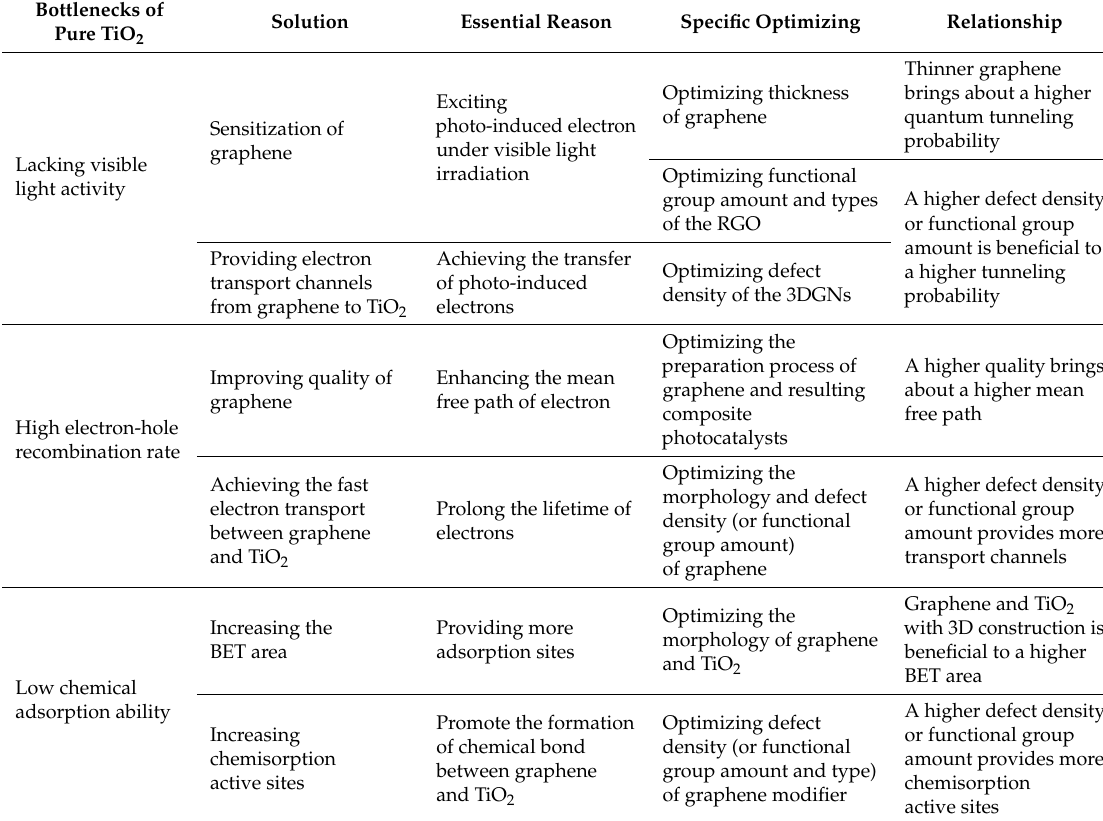
Table 1. Relationship between photocatalytic performances and optimization technologies. Bottlenecks of Pure TiO